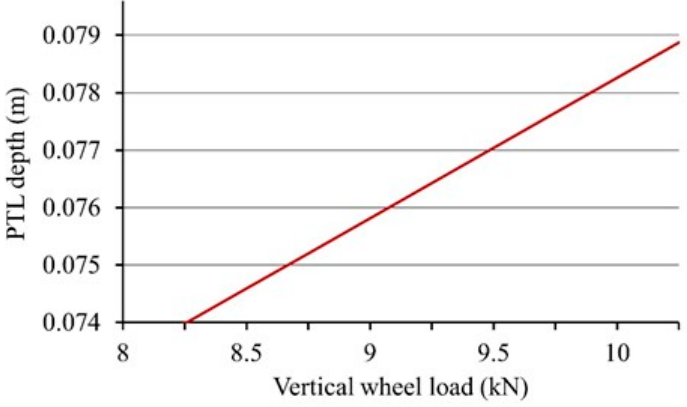
Figure 5. Dependence of the PTL track depth ( ℎ ) on the vertical load on the tractor wheel ( N w ). With increasing soil density ρ , the depth h of the PTL trace naturally decreases (Fig- ure 6). The same occurs with increasing soil cone index (Figure 7).